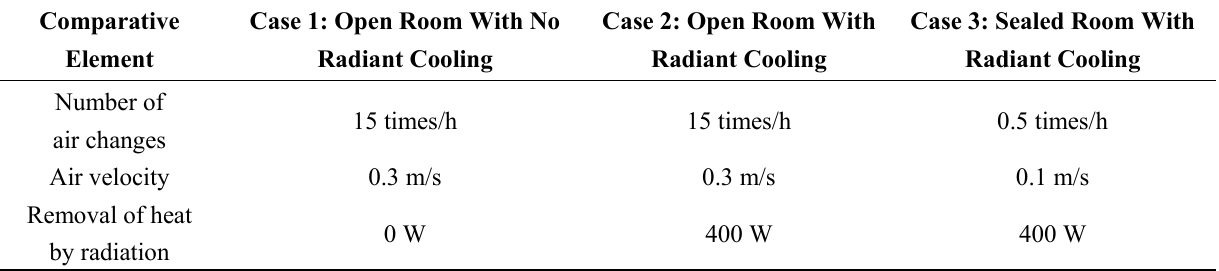
Table 1. Comparison of conditions.